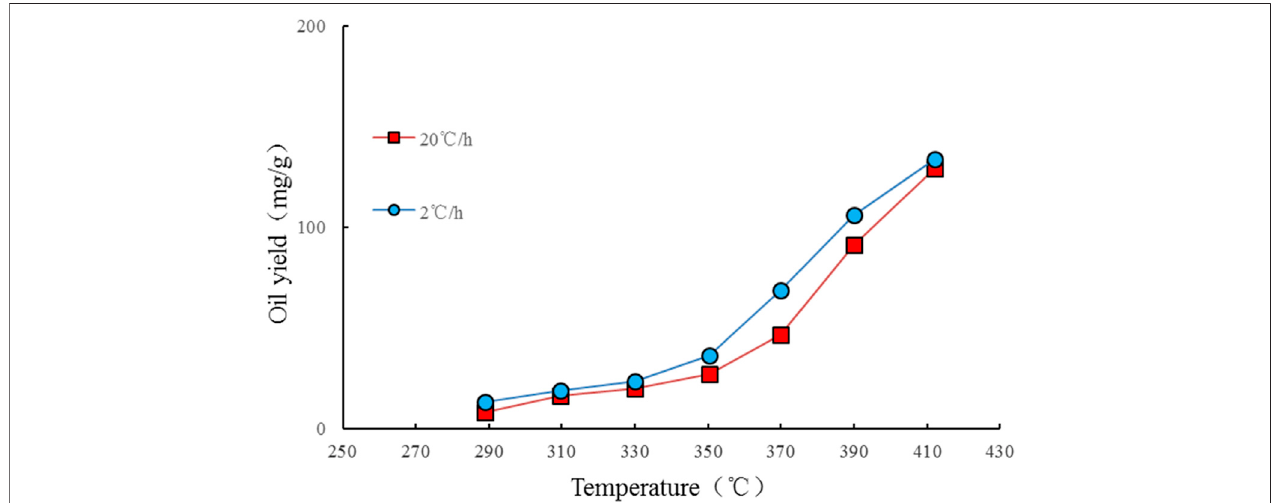
FIGURE 7 | Phased oil yields at different heating rates of sample 2,911 in the closed system.